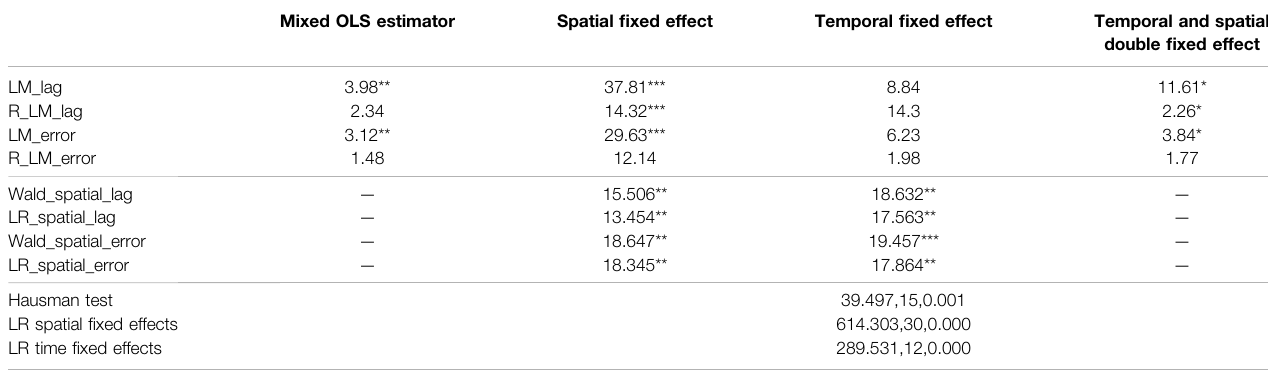
TABLE 7 | Estimation results without spatial interactive effects.